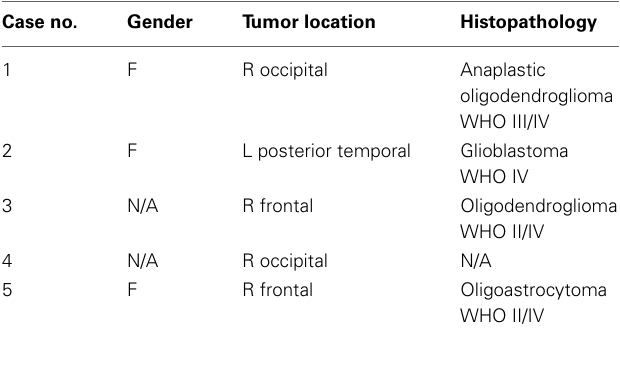
Table 1 | Patient information of five cases from SPL of Harvard medical school.